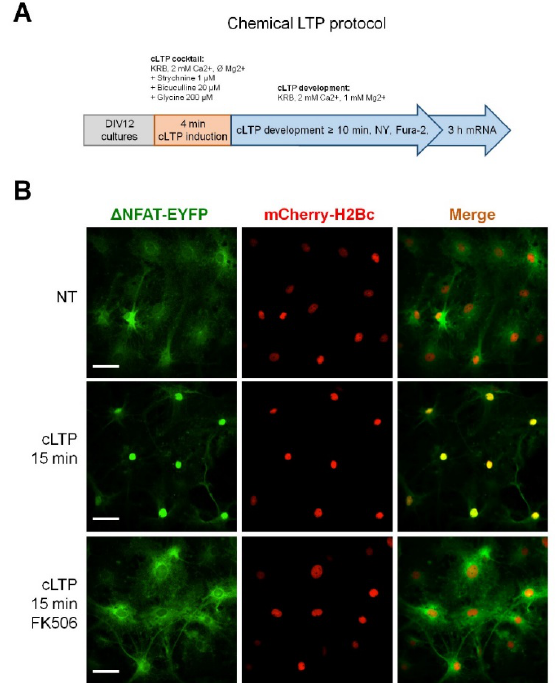
Figure 2. cLTP-induced NY nuclear translocation in astrocytes is CaN-dependent. ( A ) Scheme depicting cLTP induction protocol with consequent readouts. ( B ) Application of cLTP protocol to mixed neuron-astroglial hippocampal primary cultures induces robust NY translocation into the astrocyte nucleus at 15 min after cLTP induction phase. Note the complete inhibition of NY translocation when CaN inhibitor, FK506, was added during the cLTP development phase. Bar, 30 µ